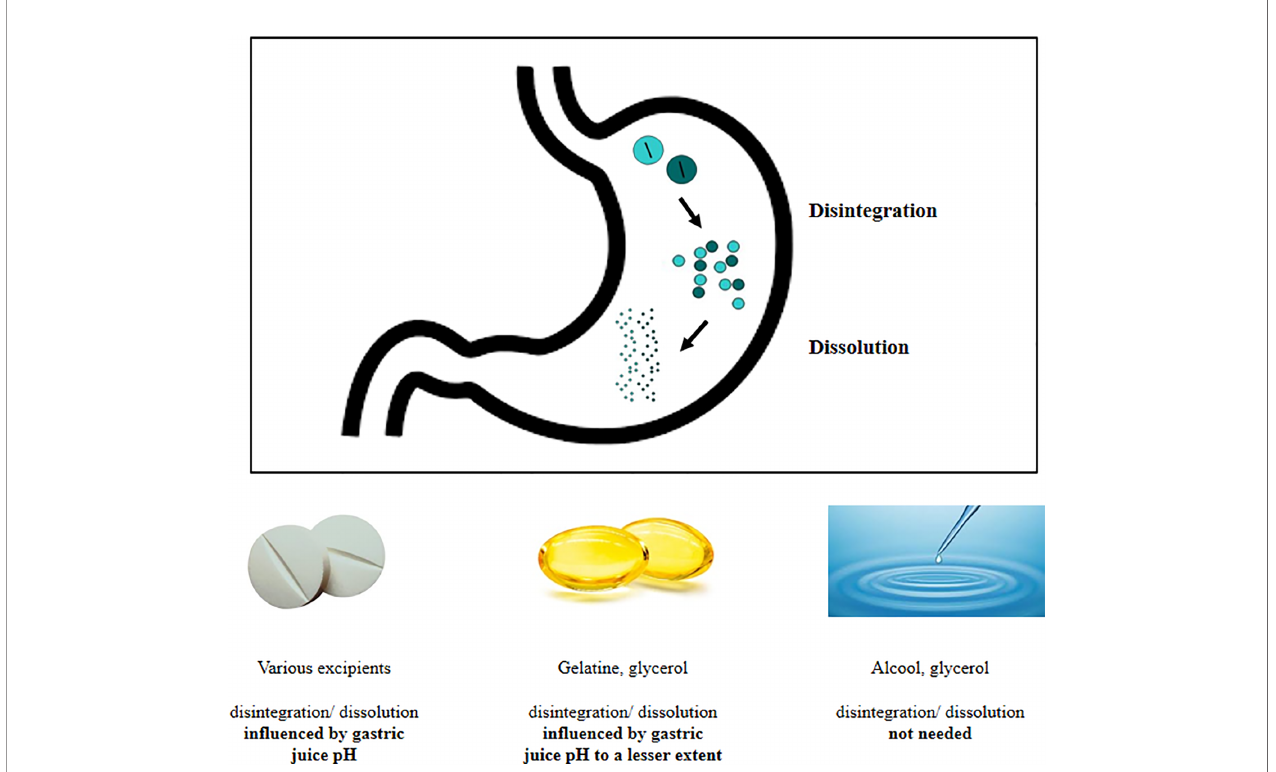
FIGURE 1 | Delivery of active ingredient at gastric level: behavior of different thyroxine